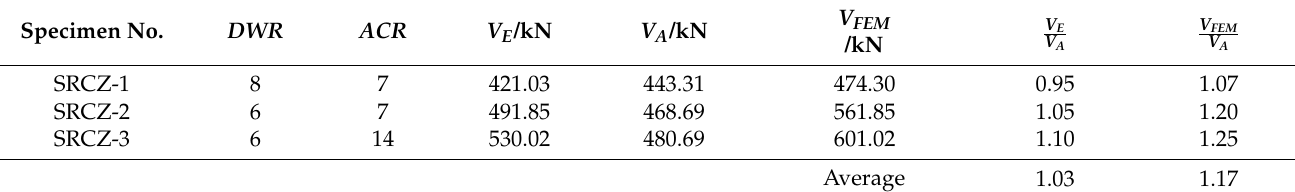
Table 7. The Experimental, Calculated and Simulated